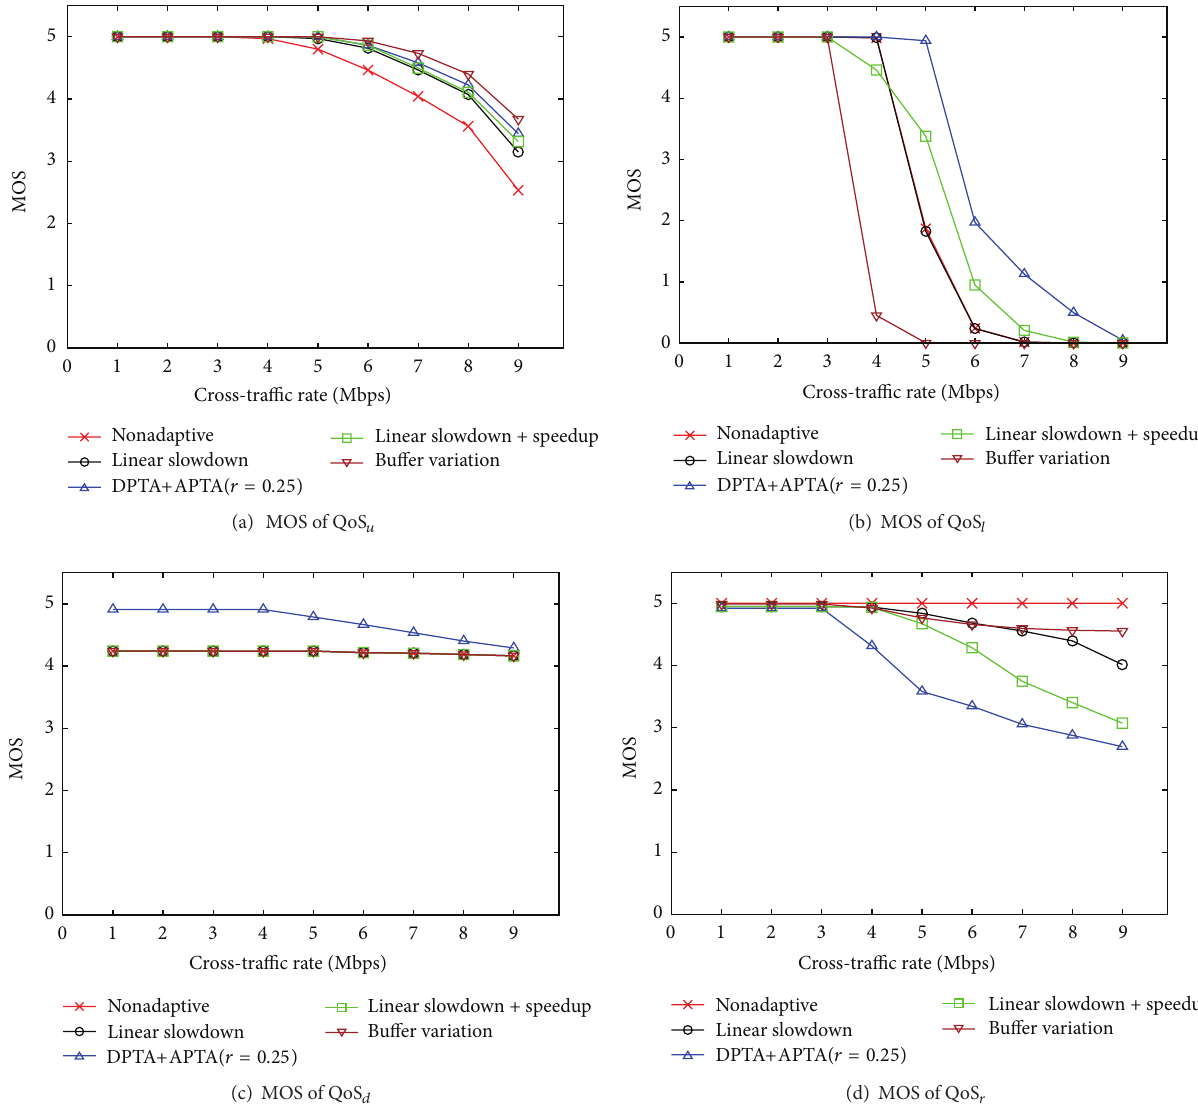
Figure 5: Corresponding QoEs of individual QoS metrics for different playout